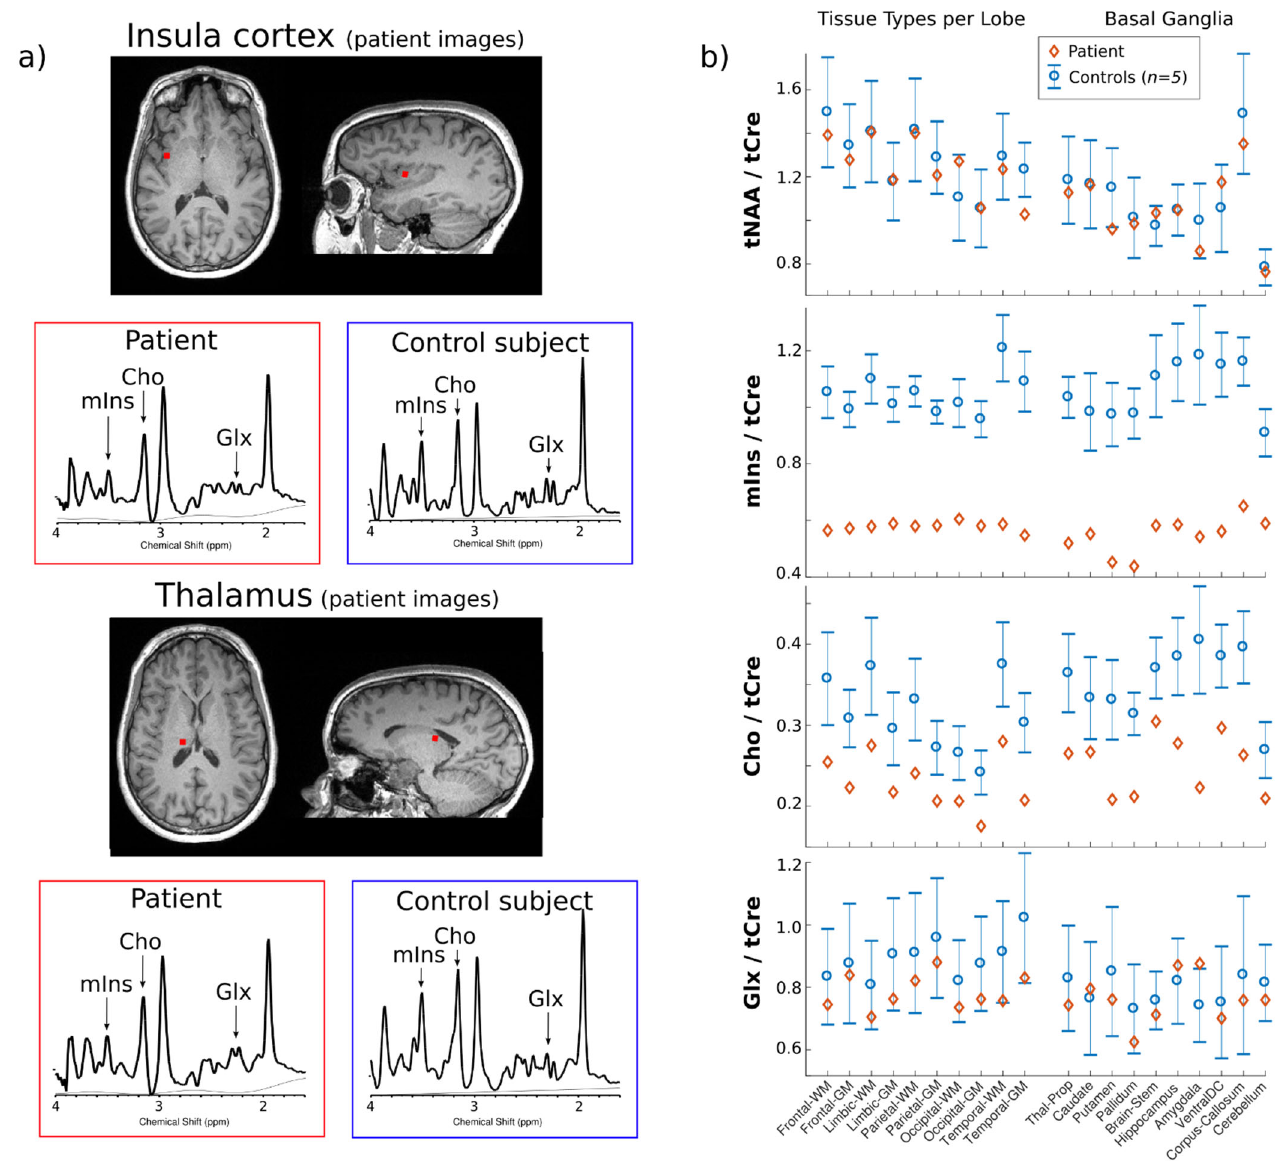
Figure 2. MRSI spectra measured in the insula cortex and the thalamus of the patient (corresponding voxel in red shown on anatomical T1 ‐ weighted images) ( a ). For comparison, spectra from the same structures are shown for a healthy subject. The drop of choline containing compounds (Cho) and inositol (Ins) in peak intensity is particularly visible in the patient spectra whereas the glutamate + glutamine (Glx) peaks show no clear alteration. These observations are confirmed by an analysis of the metabolite concentration over the whole patient brain ( b ). Regional quantitative values are shown for the patient (red diamonds) and the controls (blue circles represent the mean of the 5 with the standard deviation as error bar). The metabolite concentration ratios Ins/creatine + phosphocreatine (tCre) and Cho/tCre show systematic and distinct lower levels in the patient compared to the control group. N ‐ acetylaspartate + N ‐ acetyl aspartylglutamate (tNAA)/tCre and glutamate + glutamine (Glx)/tCre show no clear difference. MRSI, magnetic resonance spectroscopic imaging.